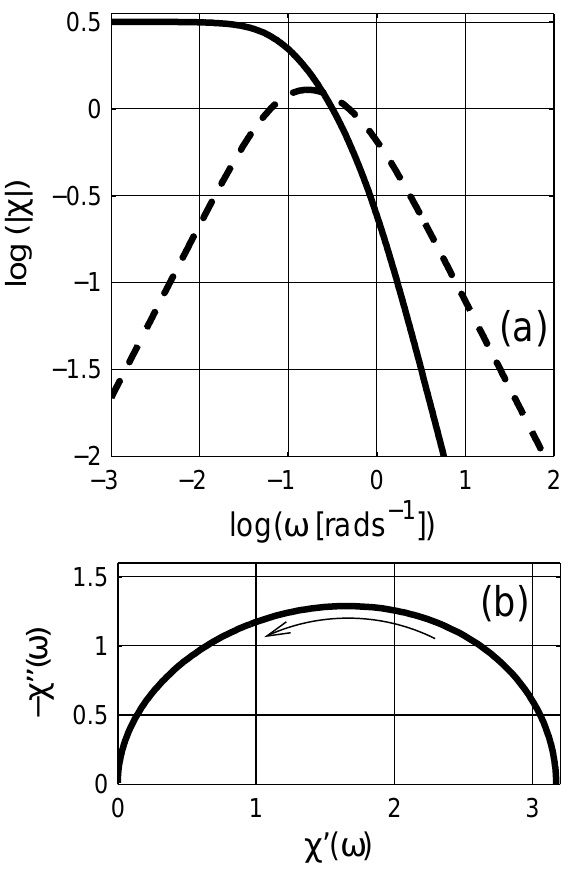
Figure 7 . (a) Dielectric susceptibility χ as a function of angular frequency ω ; the real and the imaginary parts are presented with the solid (——–) and dashed (– – –) lines, respectively. The arrow indicates the direction of increasing angular frequency ω . (b) The Argand diagram (Cole-Cole plot) of susceptibility. Logarithmic scale is base 10.